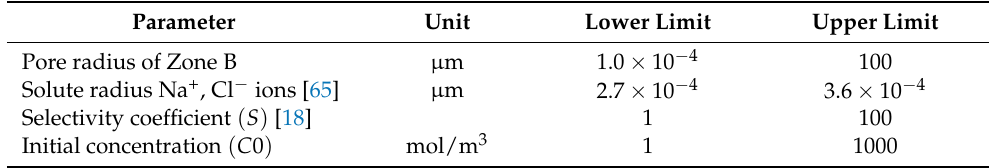
Table 3. Parameters of the numerical